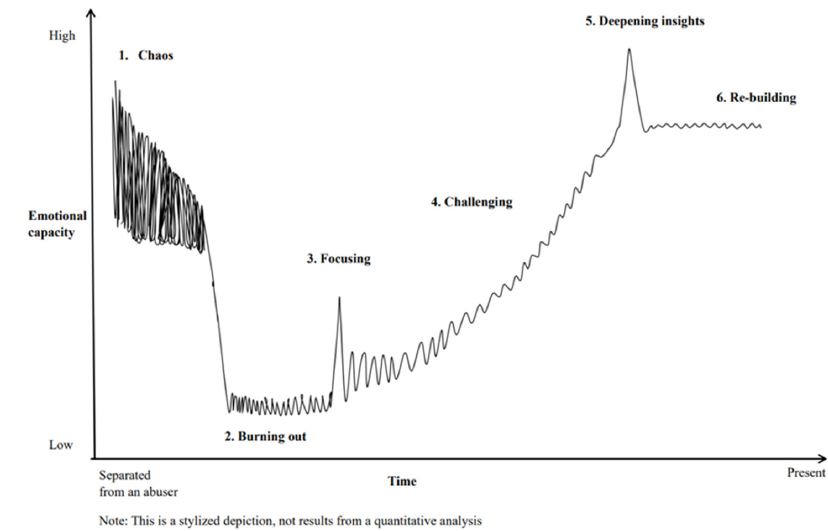
Figure 1. Recovery process to trauma integration.